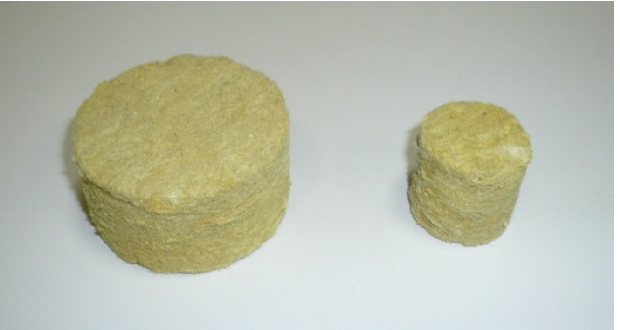
Figure 8. Nobasil from mineral fibers.